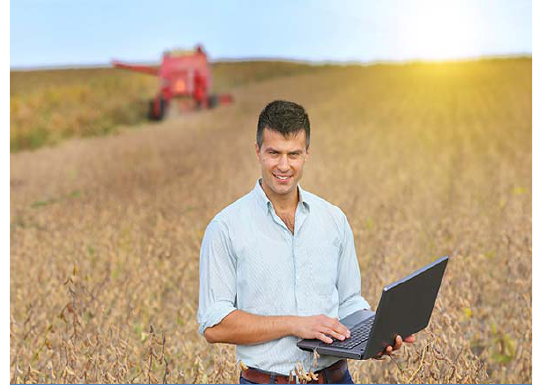
Figure 1. New consumers of Earth observation data are not mathematicians or scientists. They require information tailored to their needs with an easy-to-use